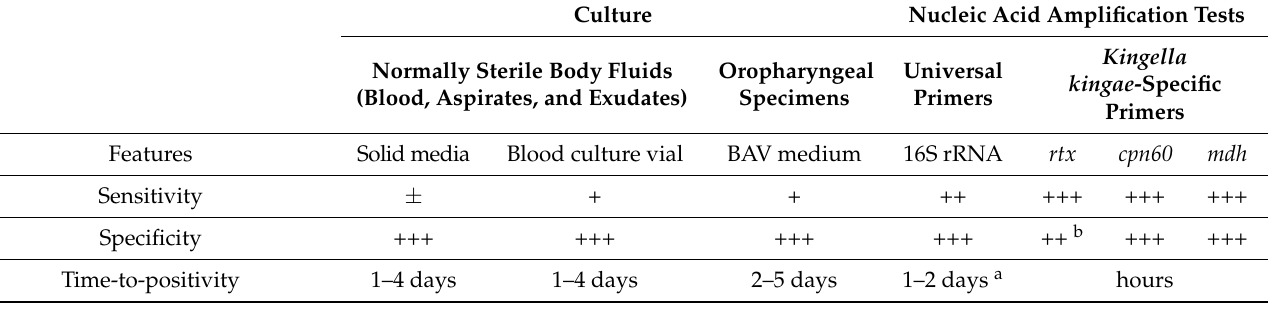
Table 1. Performance of Kingella kingae detection by culture and nucleic acid amplification test